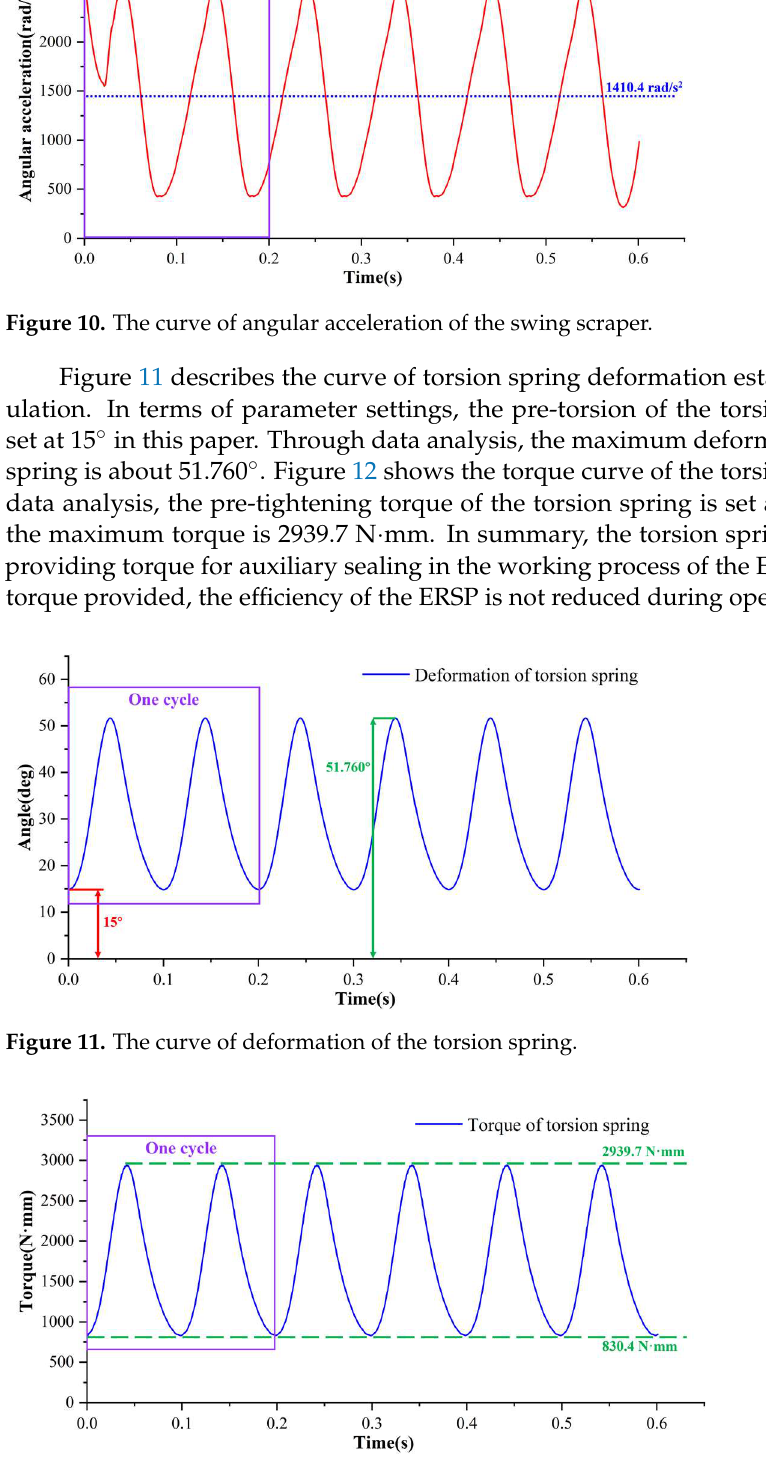
Figure 13. The curve of contact force. 4.2..4.2. .Followability Analysis In the ordinary operation of the ERSP, it is necessary to ensure that the swing scraper big end is always close to the elliptical rotor. Therefore, it is essential to analyze and study the following ability of the swing scraper relative to the elliptical rotor. In engineering practice, in order to make the scraper adapt faster to the rotor speed, we can increase the reverse torque of the swing scraper by adjusting the stiffness of the torsion spring. In addition, the pressure difference between high-pressure and low-pressure cavities is also variable under different working conditions. Therefore, when the above parameters are changed, the maximum speed of the rotor in the normal operation of the ERSP will also change. Figure 14 displays the followability analysis of the surface figure. Figure 14 clearly shows the maximum rotor speed that can make the swing scraper follow the rotor well under different torsion spring stiffness settings and various pressure differences between the high-pressure and low-pressure cavities. In the study, the torsion spring stiffness range is 56.5 N·mm/deg–615.85 N·mm/deg, and the pressure difference is 0.02 MPa–0.2 MPa. The simulation results show that the greater the stiffness of the torsion spring or the pressure difference, the better the following performance of the ERSP. The relevant matching data, obtained from the followability analysis in this section, is of great significance to follow-up research and the prototype testing of the novel pump.